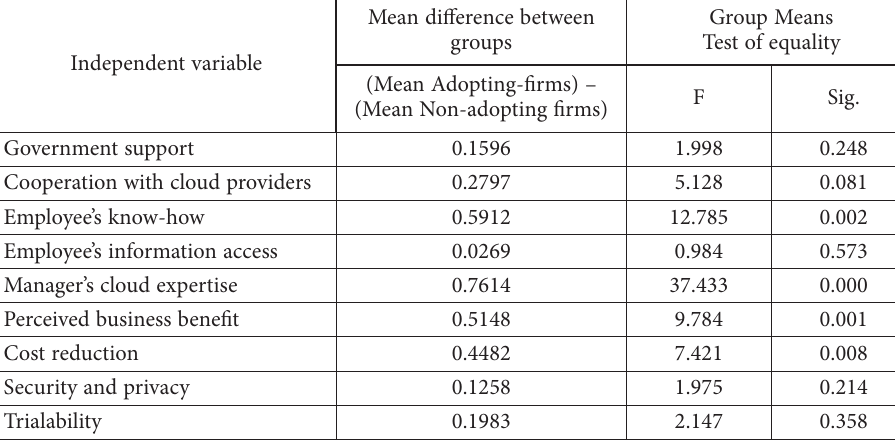
Table 13. Descriptive statistics of groups – Ony Way ANOVA